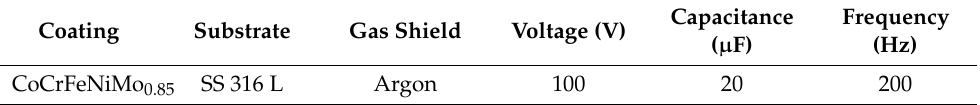
Capacitance Frequency ( µ F) (Hz)